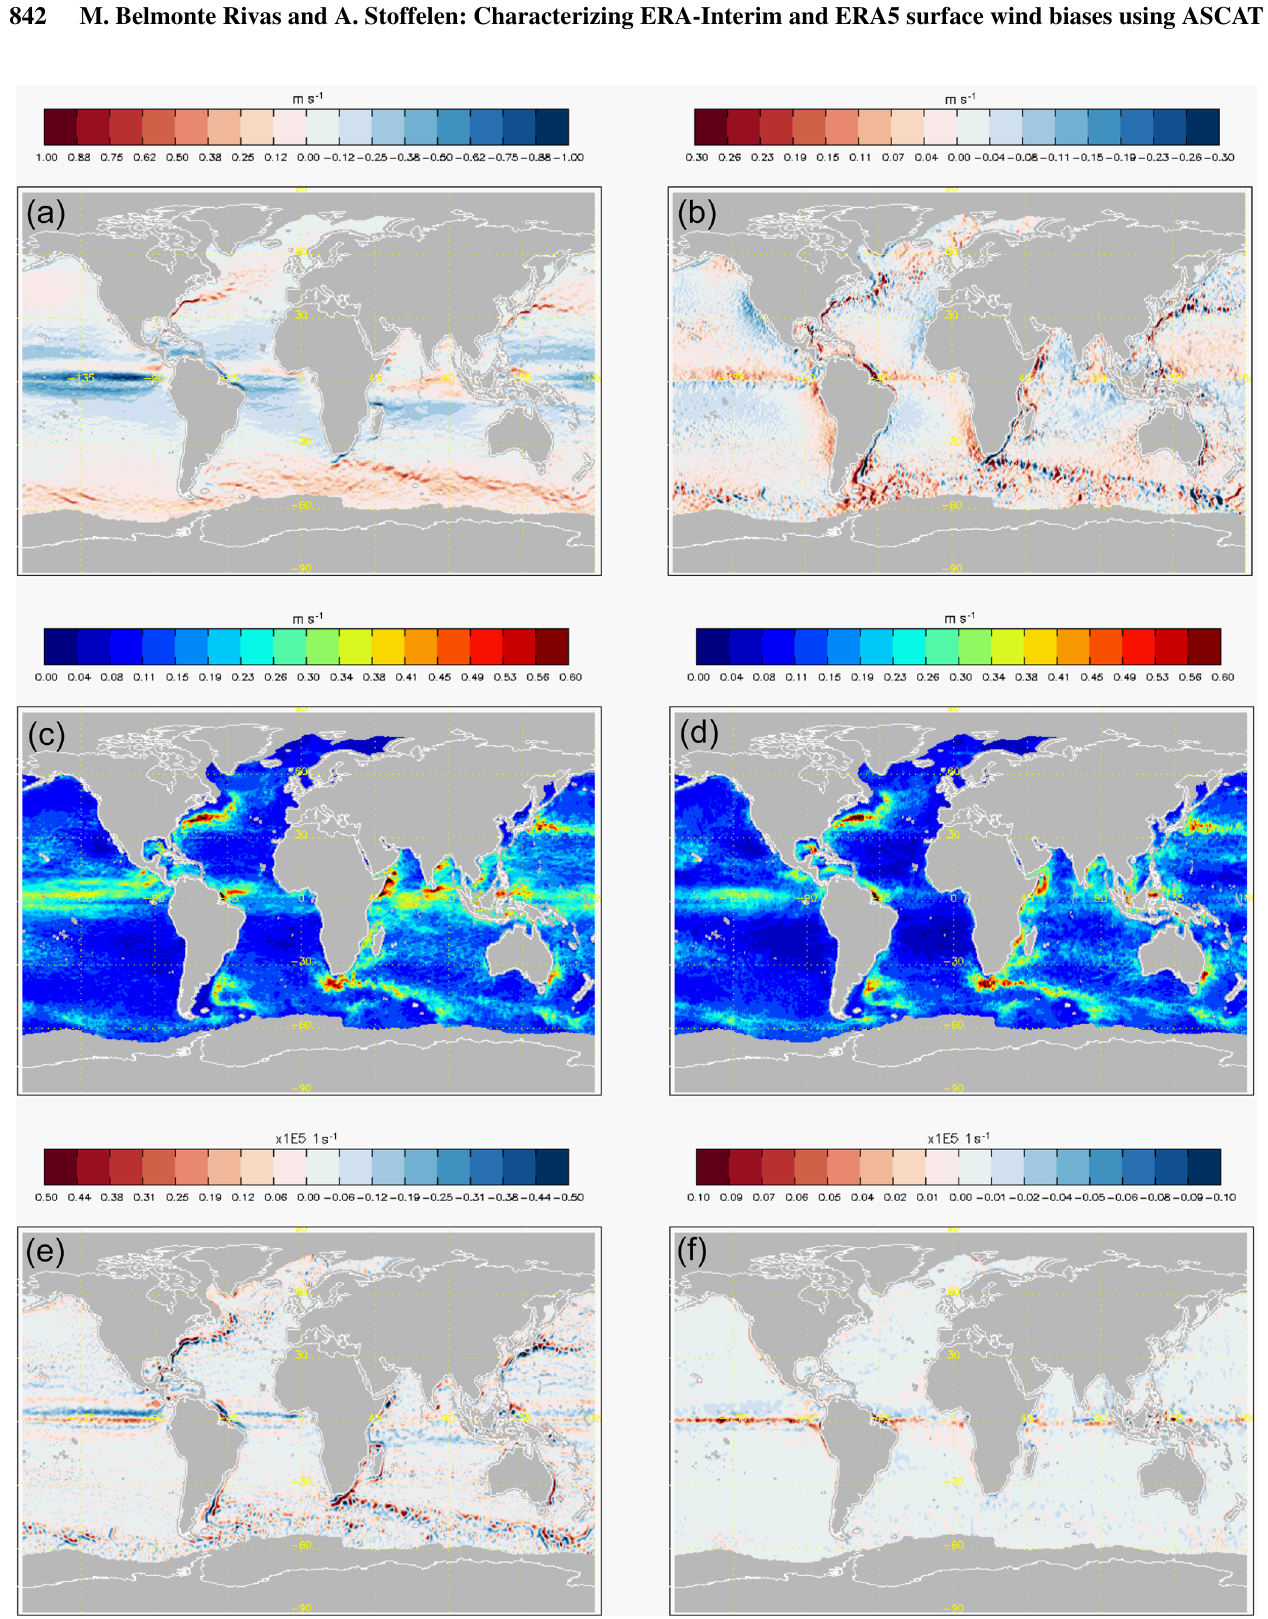
Figure 9. Ocean surface velocities: mean zonal (a) and mean meridional (b) components, along with the transient zonal (c) and transient meridional (d) components over 2016. The ocean vorticity and divergence are shown in (e) and (f)